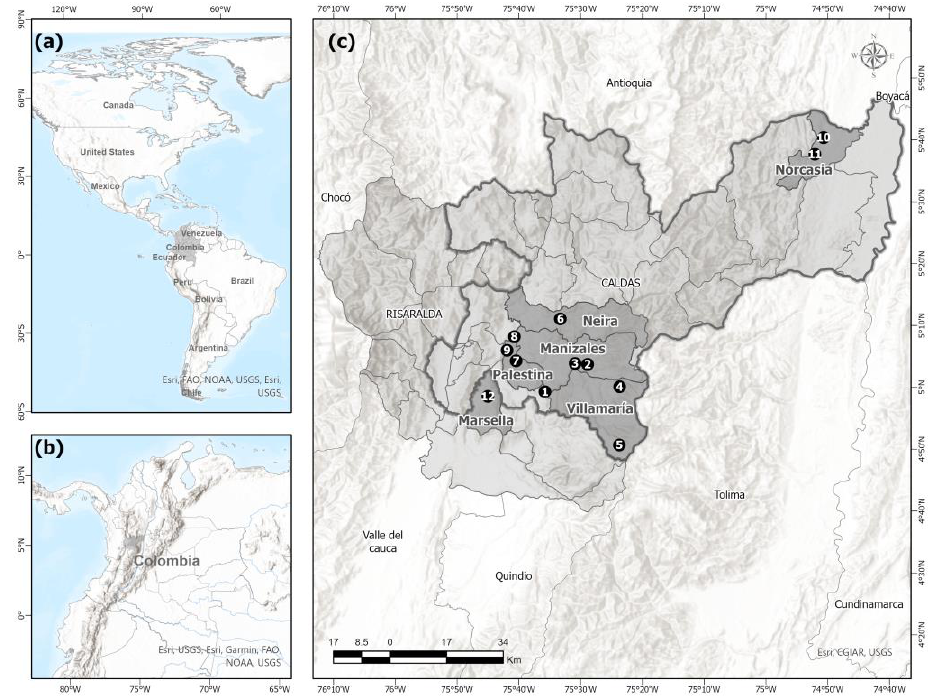
Figure 1. Study area. ( a ) American Continent, ( b ) Colombia, ( c ) Departments of Caldas and Risaralda, Colombia. Sampled localities in the municipalities of Manizales, Villamaría, Neira, Palestina, Norcasia, and Marsella. (1) Centro Nacional de Investigaciones de Café (CENICAFÉ). (2) Ecoparque Los Yarumos. (3) Jardín Botánico de la Universidad de Caldas. (4) Bosques de la CHEC. (5) Sector Santa Bárbara, finca El Edén. (6) Entrada Cementos Caldas. (7) Granja Montelindo de la Universidad de Caldas. (8) Vereda El Retiro. (9) Kilometro 35, Escuela. (10) Vereda Las Delicias, sector La Punta. (11) Vereda La Estrella, Finca El Encanto. (12) Río Cauca, túnel La Mica. Map created in ArcGis Pro 2.8.